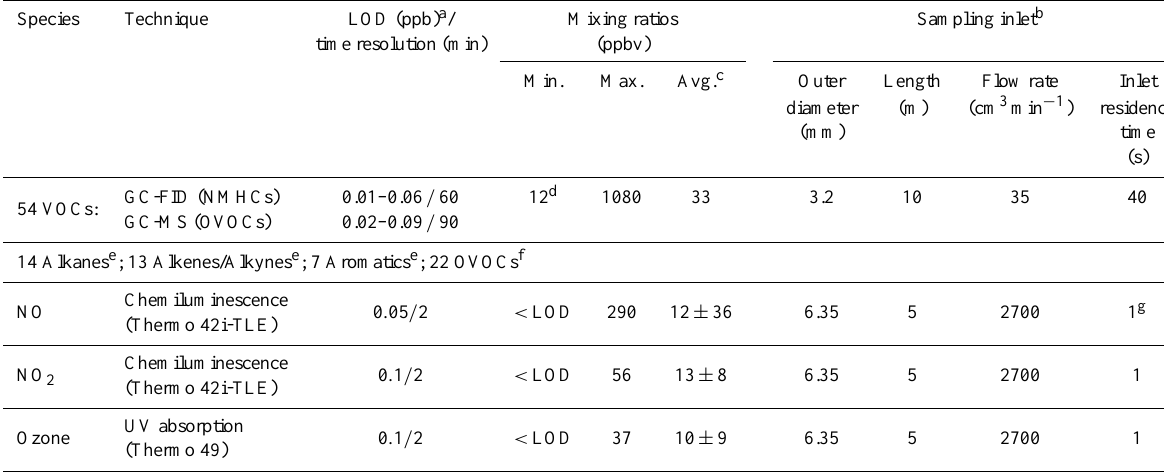
Table 3. Summary of ancillary measurements used for OH reactivity calculations. Species